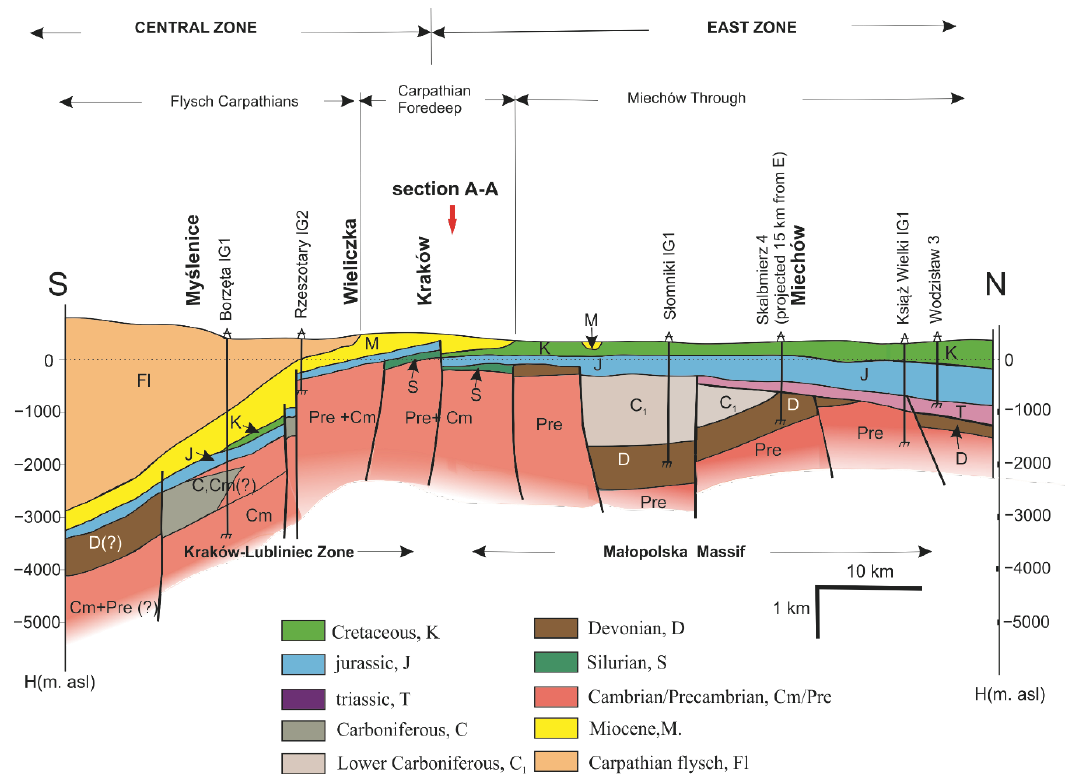
Figure 2. Schematic A–A geological cross-section through the area of analysis (based on PGNiG SA and PIG borehole data, CBDG PIG-PIB portal and according to [10,11,13]—location in Figure 1).